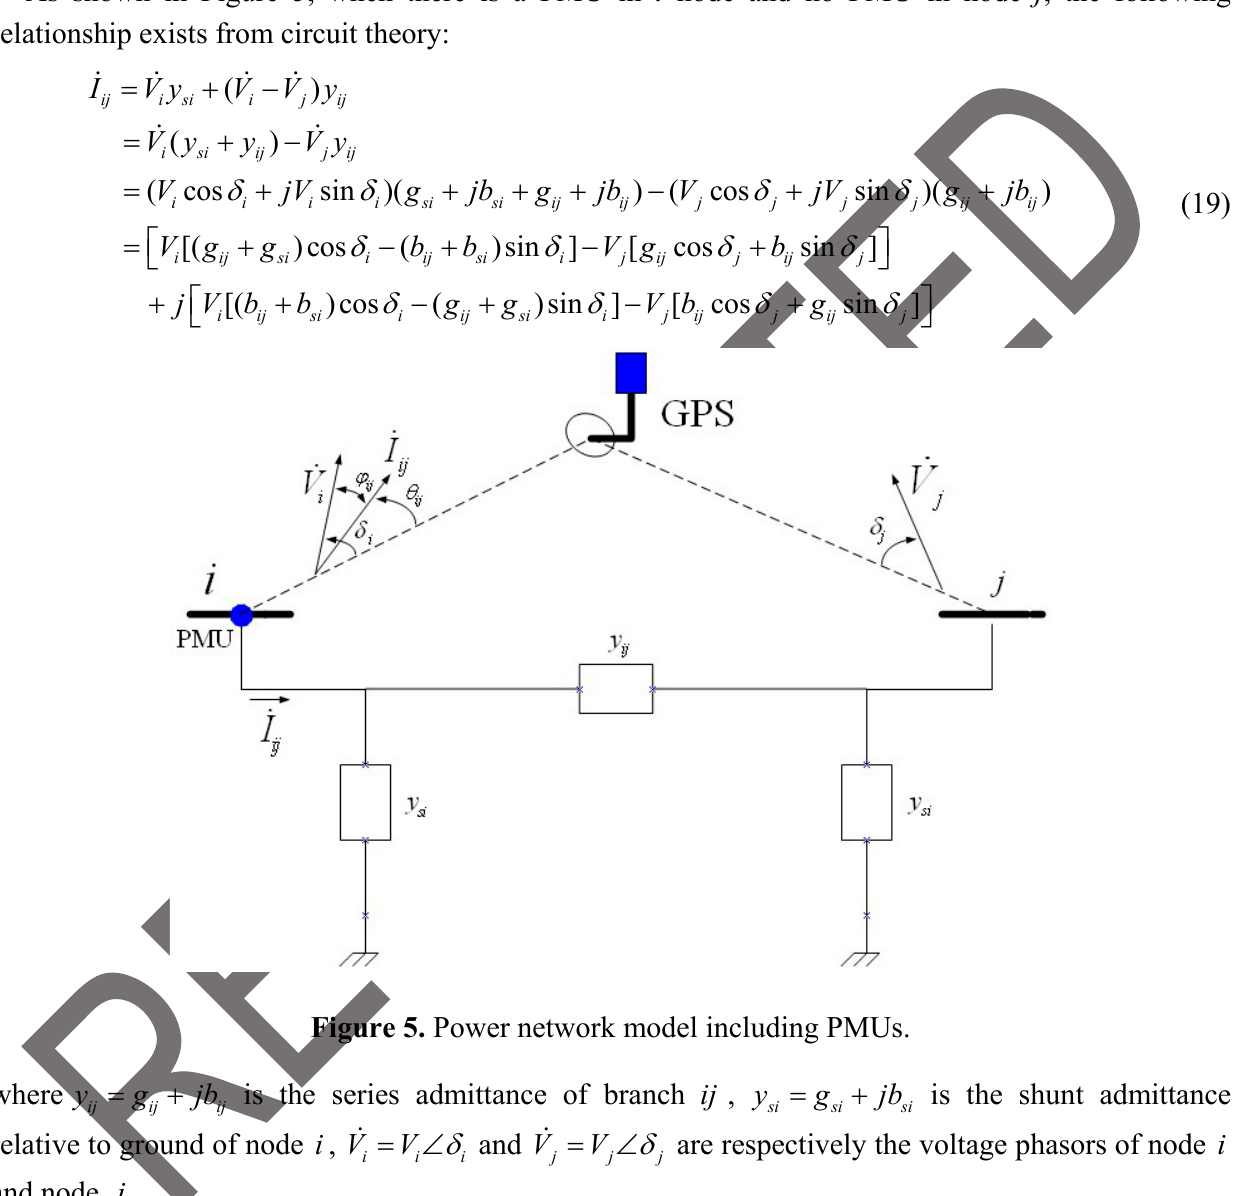
Figure 5. Power network model including